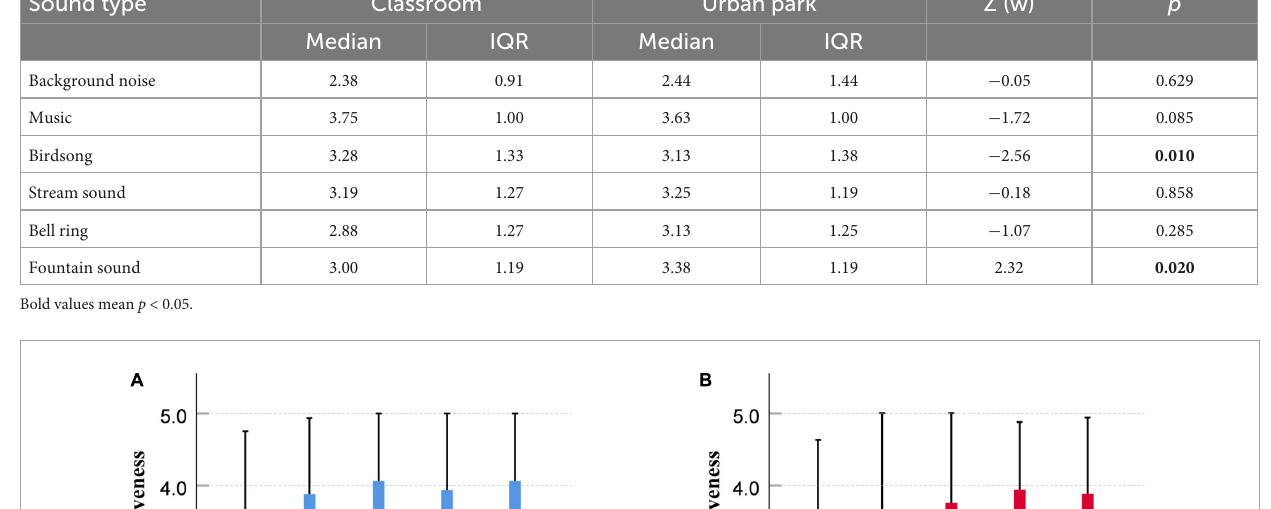
TABLE 3 Comparison of perceived restorativeness of each sound type between a classroom and urban park. Sound type